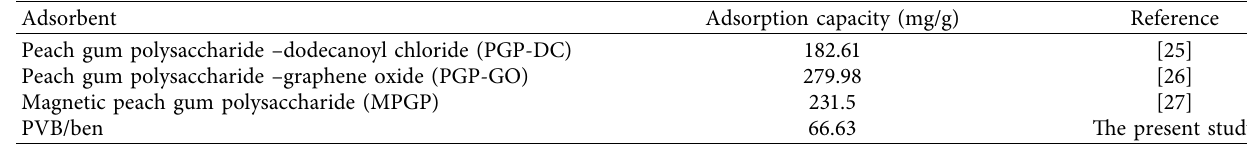
Figure 9: Efect of solution temperature on MB molecules using PVB/bentonite nanofbers at pH 9 and 500rpm. Initial dye concentration of 20mg/L. Table 2: Comparison of rates of adsorption of MB in various works.